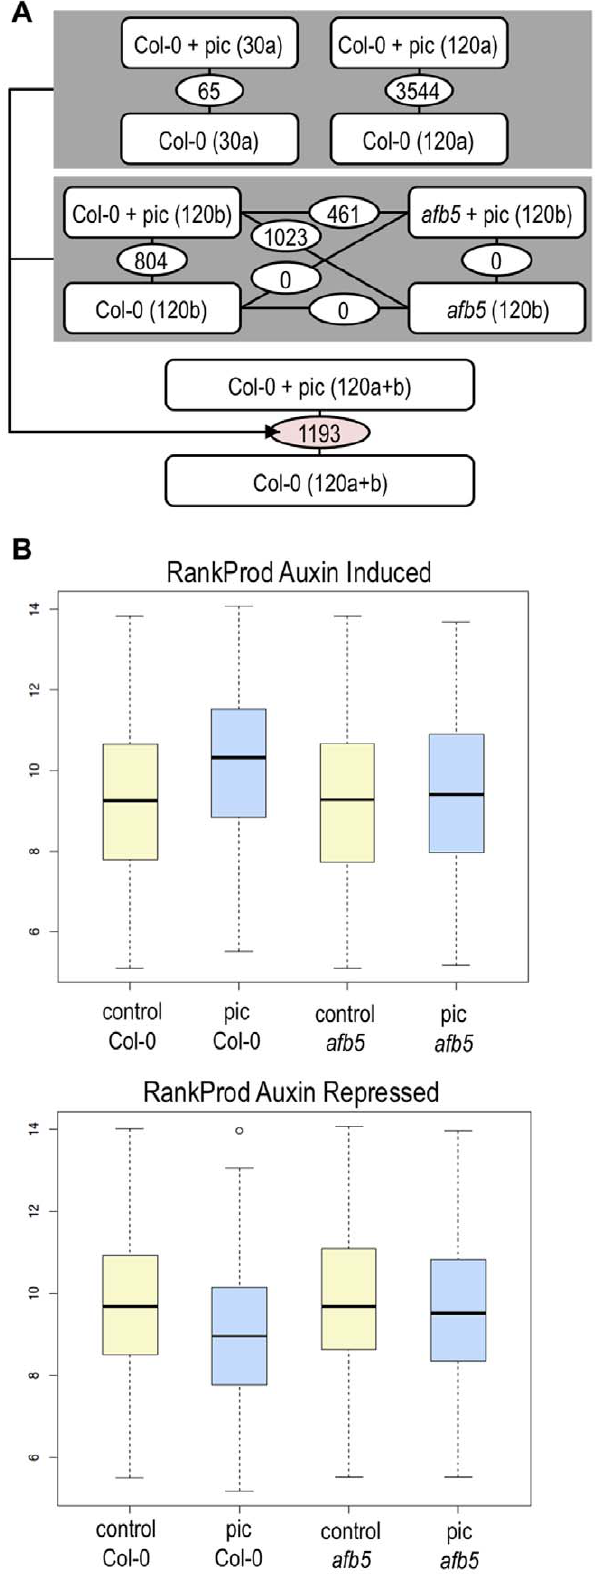
Figure 3. The afb5 mutant fails to respond to picloram. The afb5- 5 mutant fails to regulate transcription in response to picloram. Differential gene expression between hypocotyl samples of solvent-